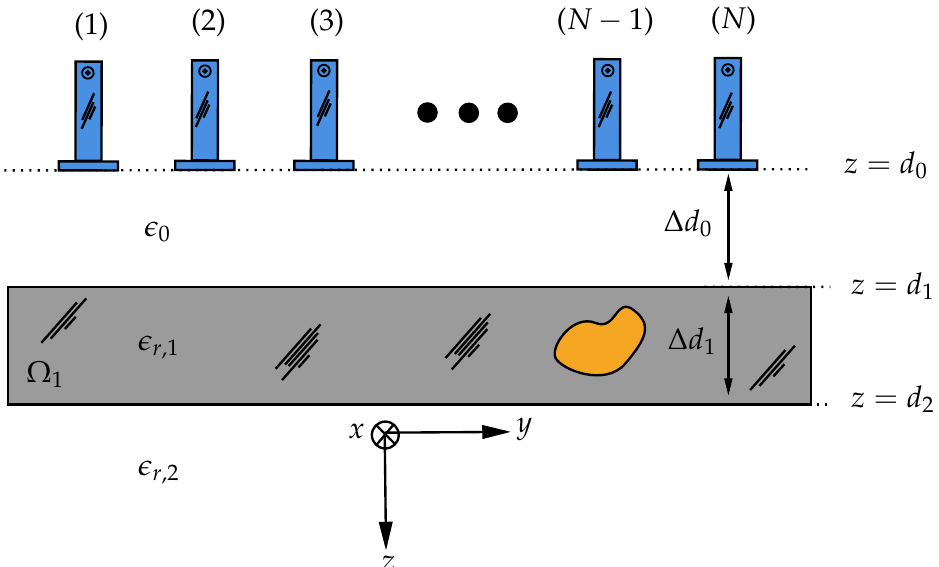
Figure 2. Multilayer media with the wet spot(s) in the second layer illuminated by the open waveg- uide